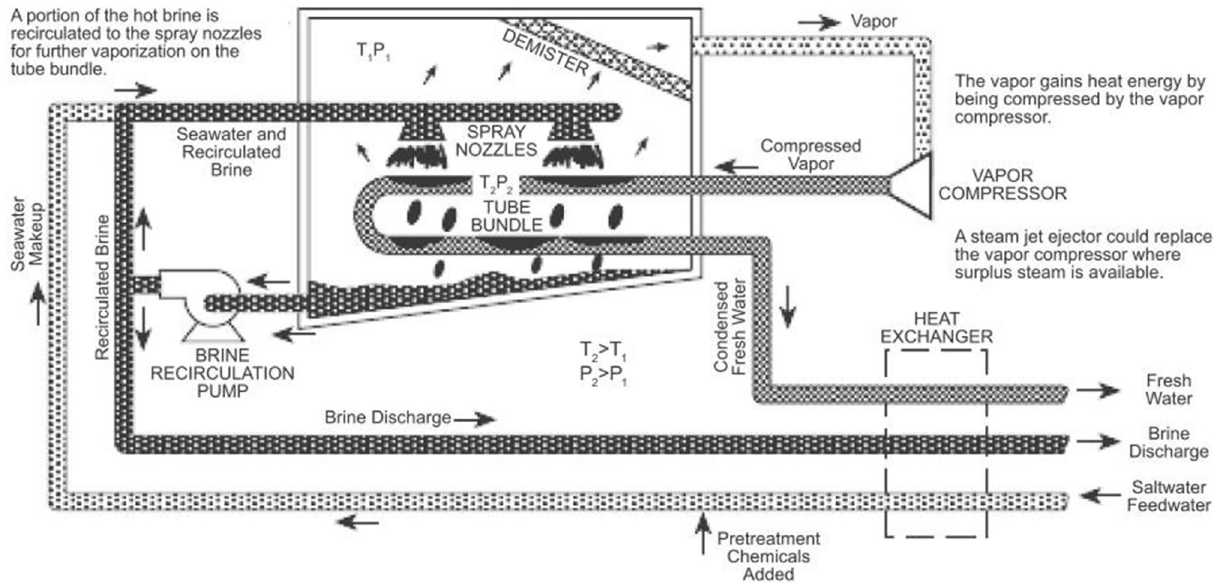
Fig. 17 The vapor compression method (Voutchkov